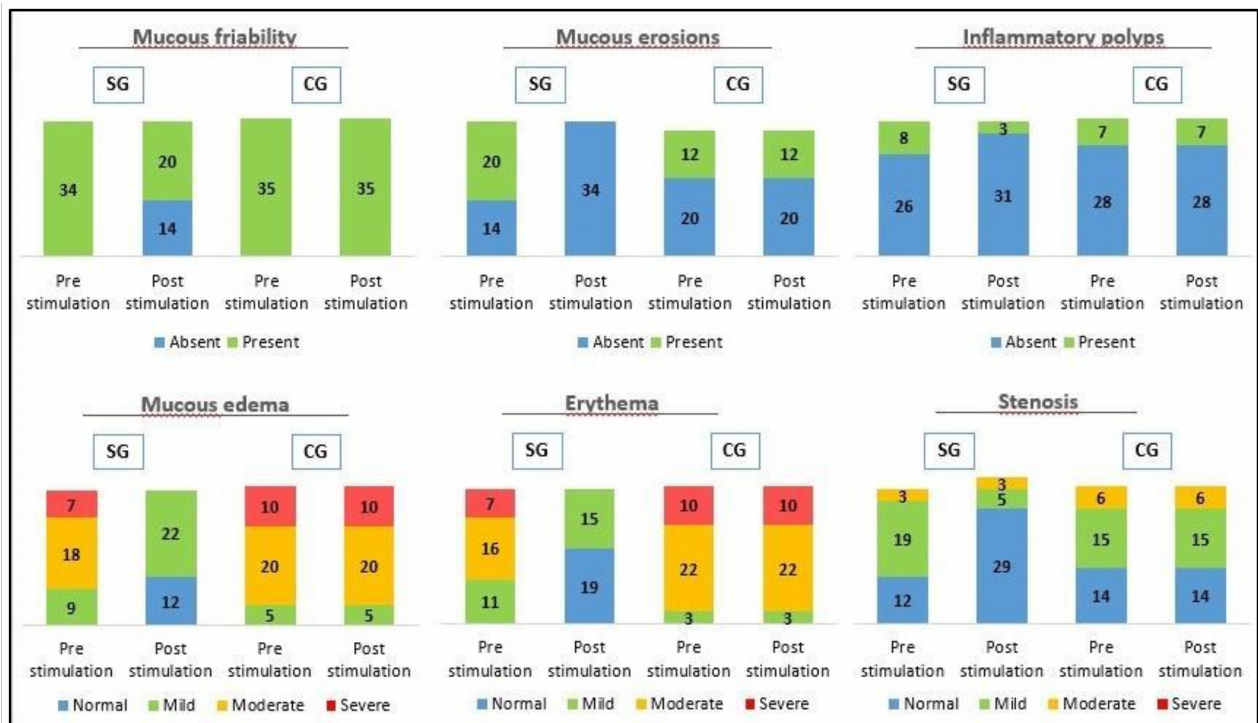
Figure 2. Macroscopic findings by endoscopy before and after stimulation in CG and SG in diversion colitis. A statistically significant decrease in endoscopic pathological findings (mucosal friability, mucous erosions, polyps, edema, erythema and stenosis) were observed in SG, with a p <